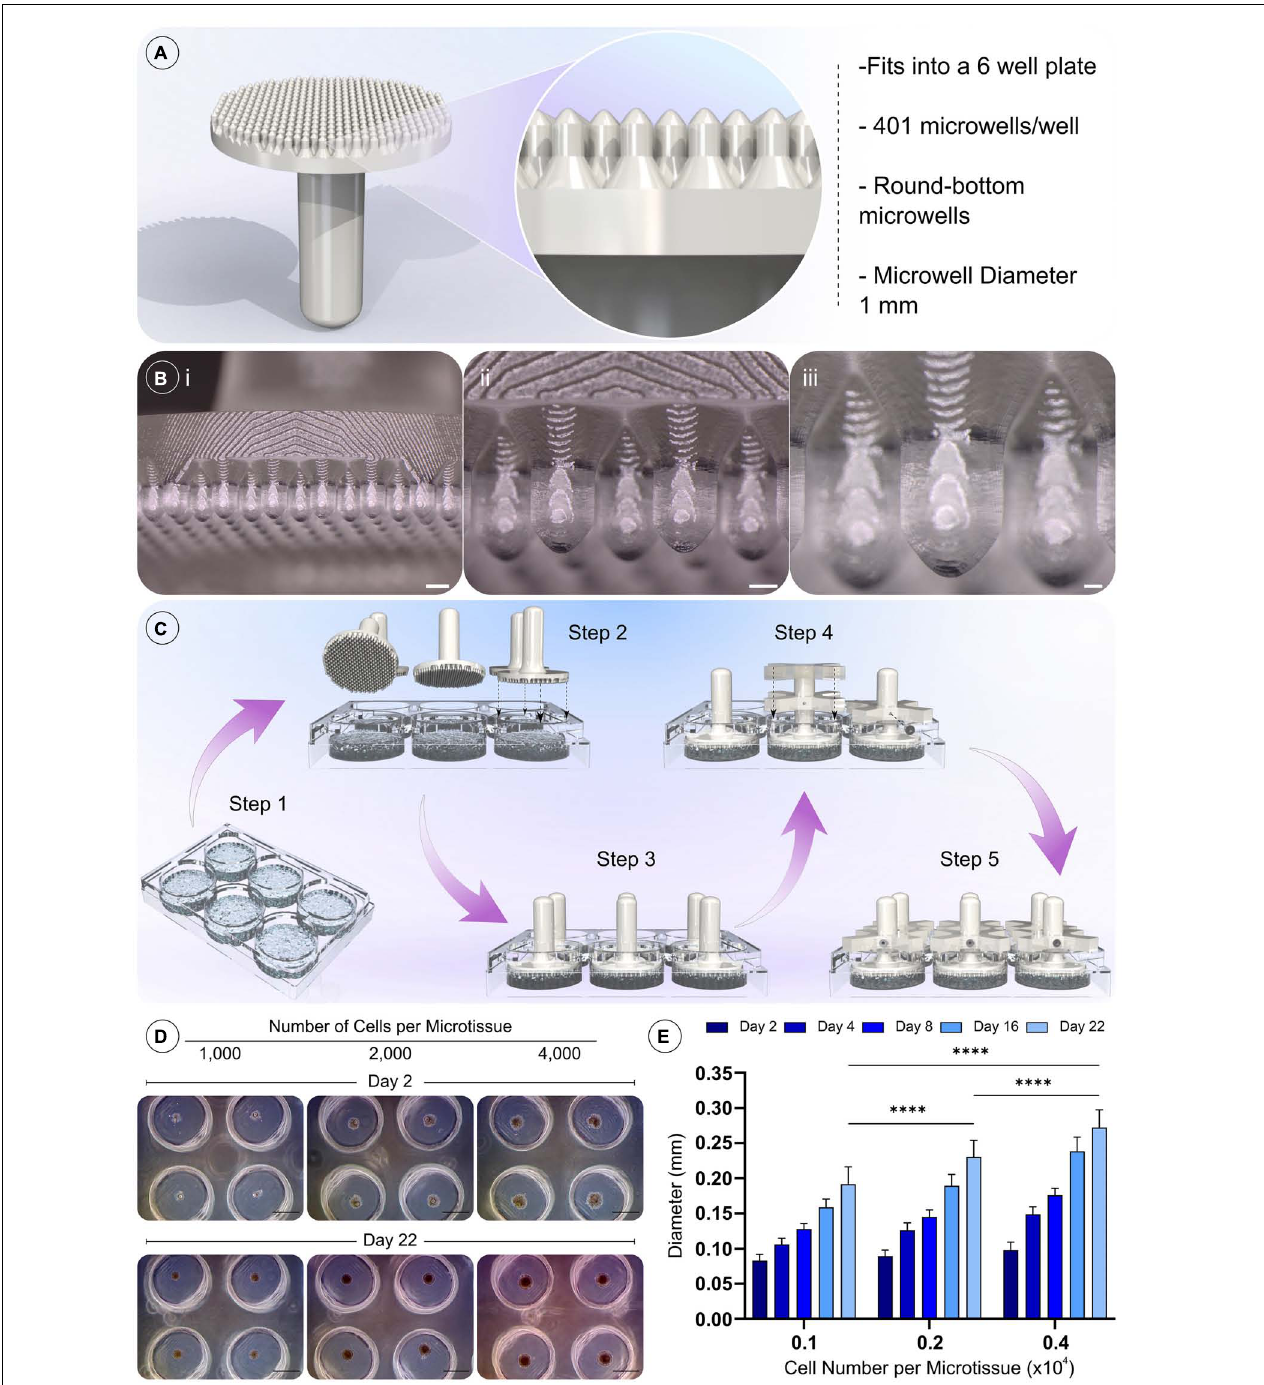
FIGURE 2 | Design of novel microwell moulds, the methodology for fabricating non-adherent microwells, and the validation of cell spheroid formation. A) Model and details of the positive mould used to generate the microwells. (Bi–iii) Macroscopic images of the 3D printed positive mould (Scale bar = 1 mm, 500 µ m, and 200 µ m, respectively). (C) Procedure for moulding the microwells. Step 1 molten agarose is added to the wells of a 6 well plate, then positive moulds are then pressed into the still molten agarose (steps 2–3). Holders are placed over the positive moulds and a grub screw inserted into the holder to prevent subsidence of the positive mould as the agarose cools (step 4). The final assembly is shown in step 5, the positive moulds are left in place until the agarose cools and solidifies. Upon removal, the cast agarose within the well is patterned with the microwell design. (D) Validation of the formation of gBMSC spheroids after 48 h, and their growth over 21 days of chondrogenic culture (Scale bar = 500 µ m). (E) Quantification of spheroid diameter change, ∗∗∗∗ denotes significance two-way ANOVA with Tukey post hoc test, p < 0.0001 ( n = 25, mean ± SD).